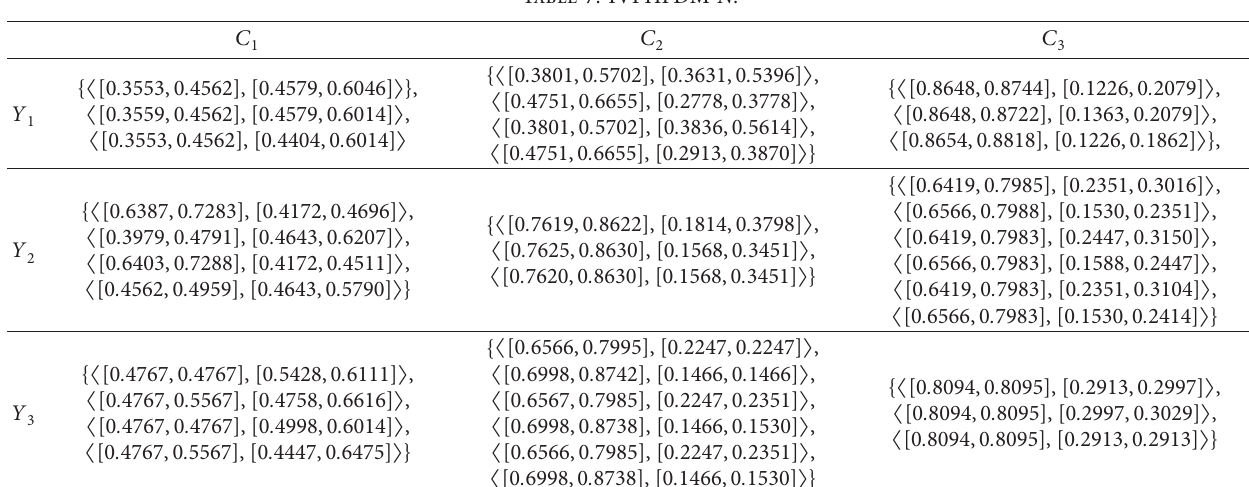
Table 7: IVPHFDM N